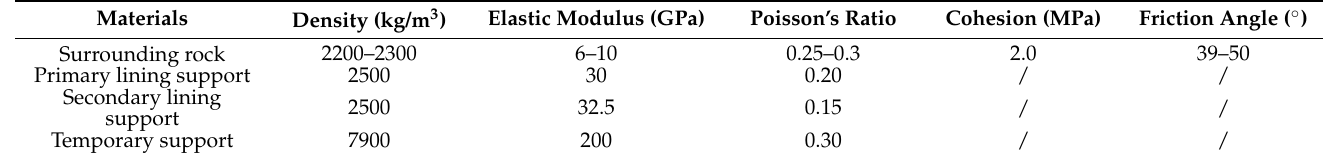
Table 2. Material parameters of the numerical model.